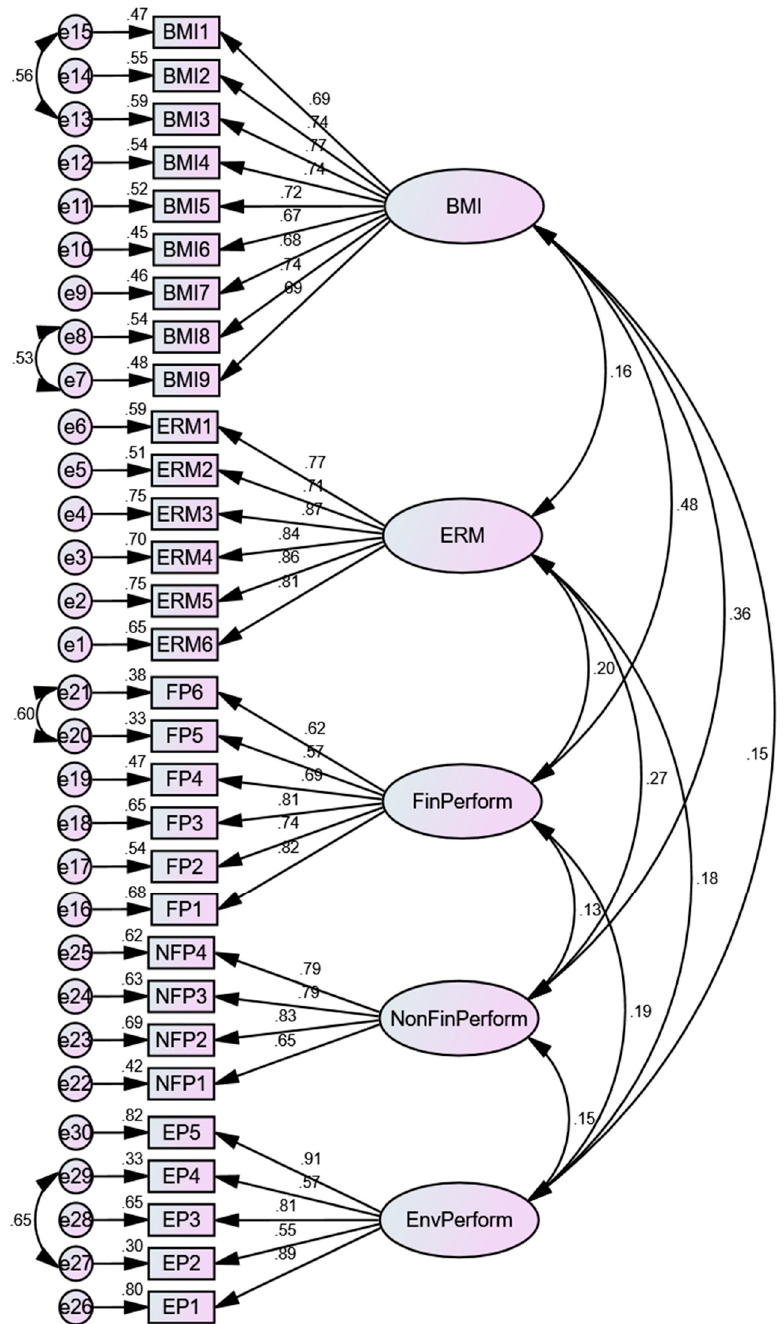
Figure 2. Measurement model. The validity and reliability results of the study are depicted in Table 3. Convergent validity indicates the average variance explained by the items in a single construct (Garver and Mentzer 1999). If the items explain 50% or more variance, it means there is satisfactory convergent validity (Garver and Mentzer 1999). Our research met the condition because all the constructs displayed adequate